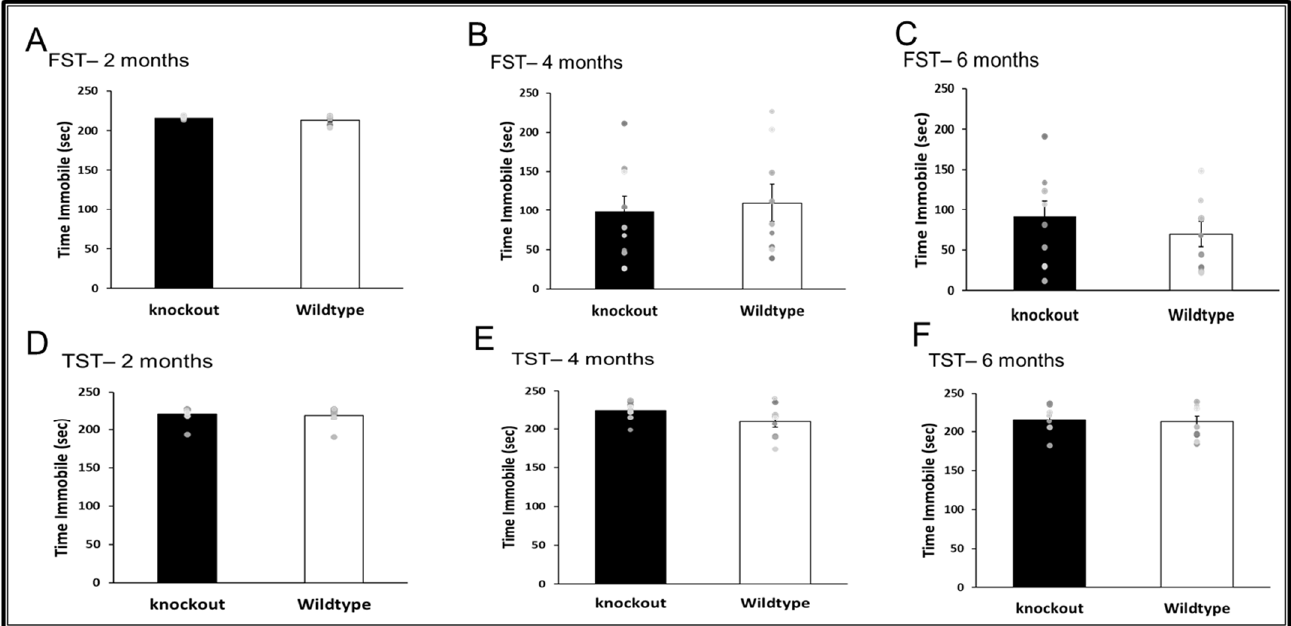
Figure 6 . The effect of CD24 knockout on depression-like behaviour. Abolition of CD24 did not change depression-like behaviour in the FST (A-C) and TST(D-F), at 2 months (A and D), 4 months (B and E) and 6 months (C and F). n = 8 mice per group.